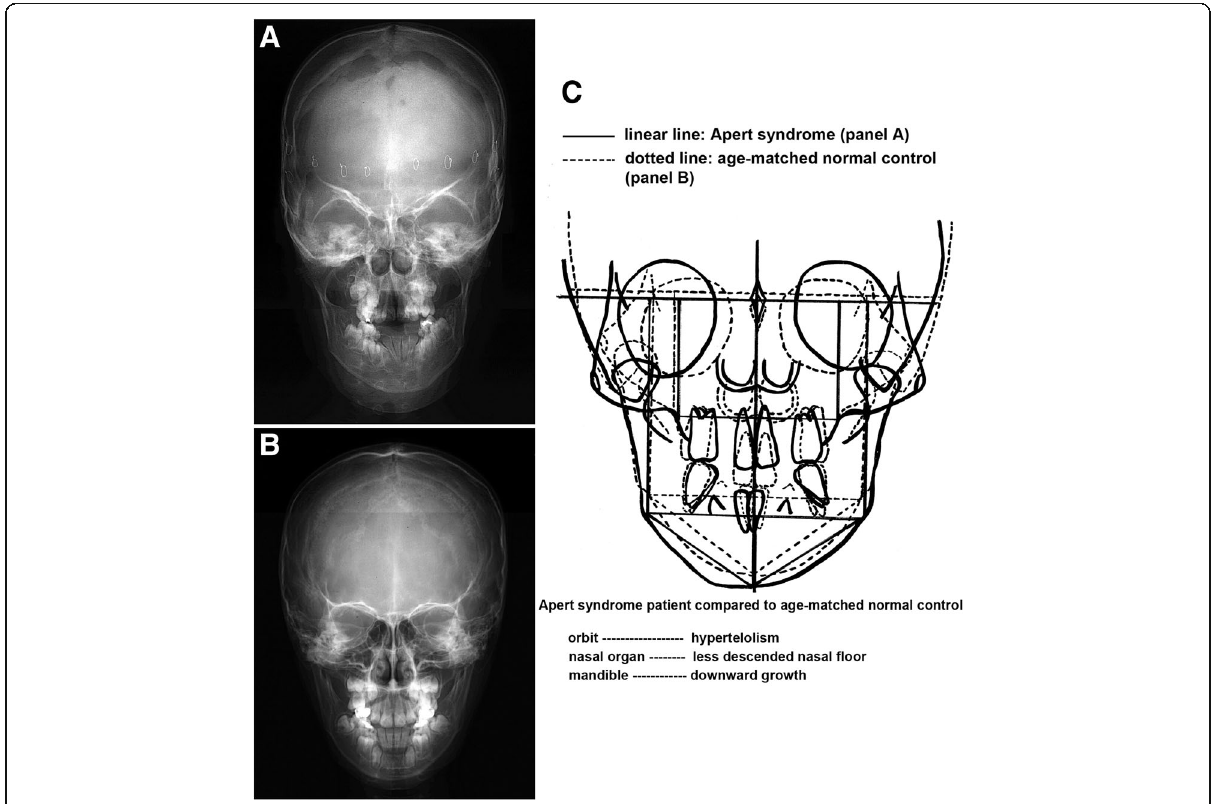
Fig. 5 Posterior to anterior (PA) view. a An Apert syndrome patient, a 9-year-old male. b A 9-year-old normal male. c Overlapping panels a and b by adjusting the line between the bilateral jugular points. The Apert syndrome patient showed orbital hypertelorism, less descended nasal floor, and downward growth of the mandible compared to the